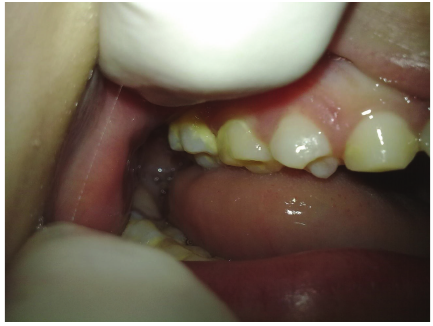
Figure 3: Oral manifestations: presence of dental calculus.